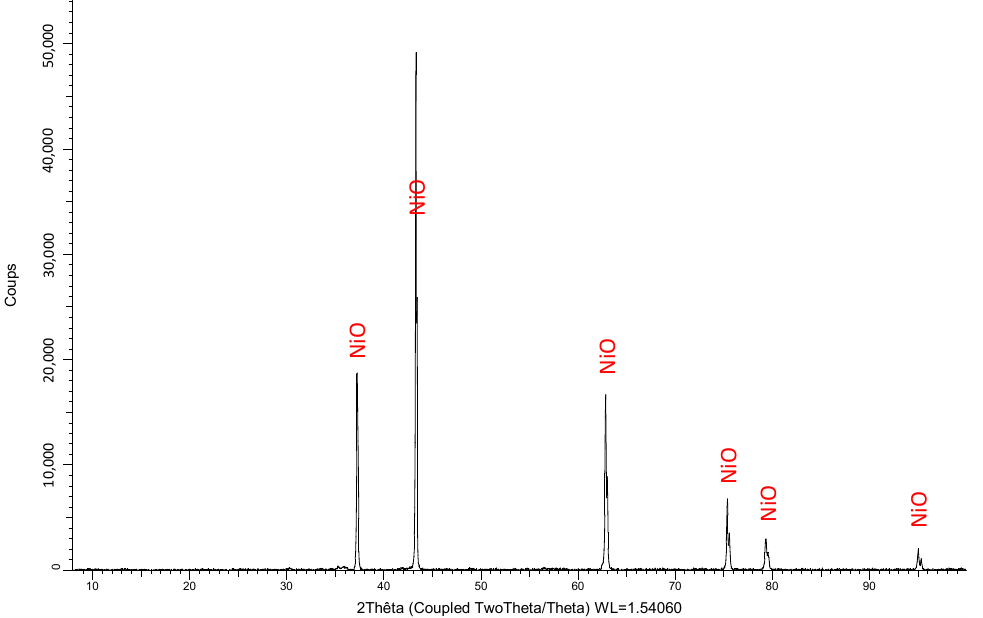
Figure 5. Diffractogram acquired on the oxidized surface of the Ni–25Cr–0.25C–1.9Zr sample.